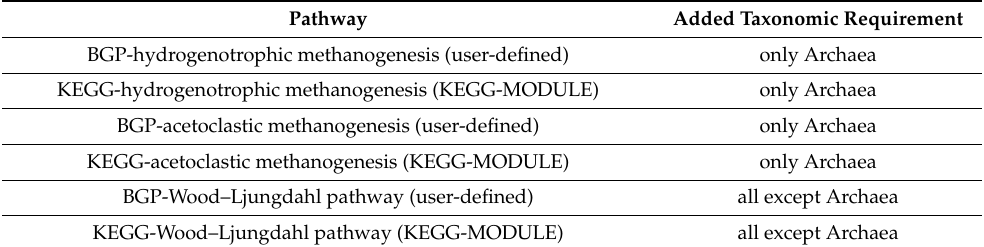
Table 2. Taxonomic classification of each